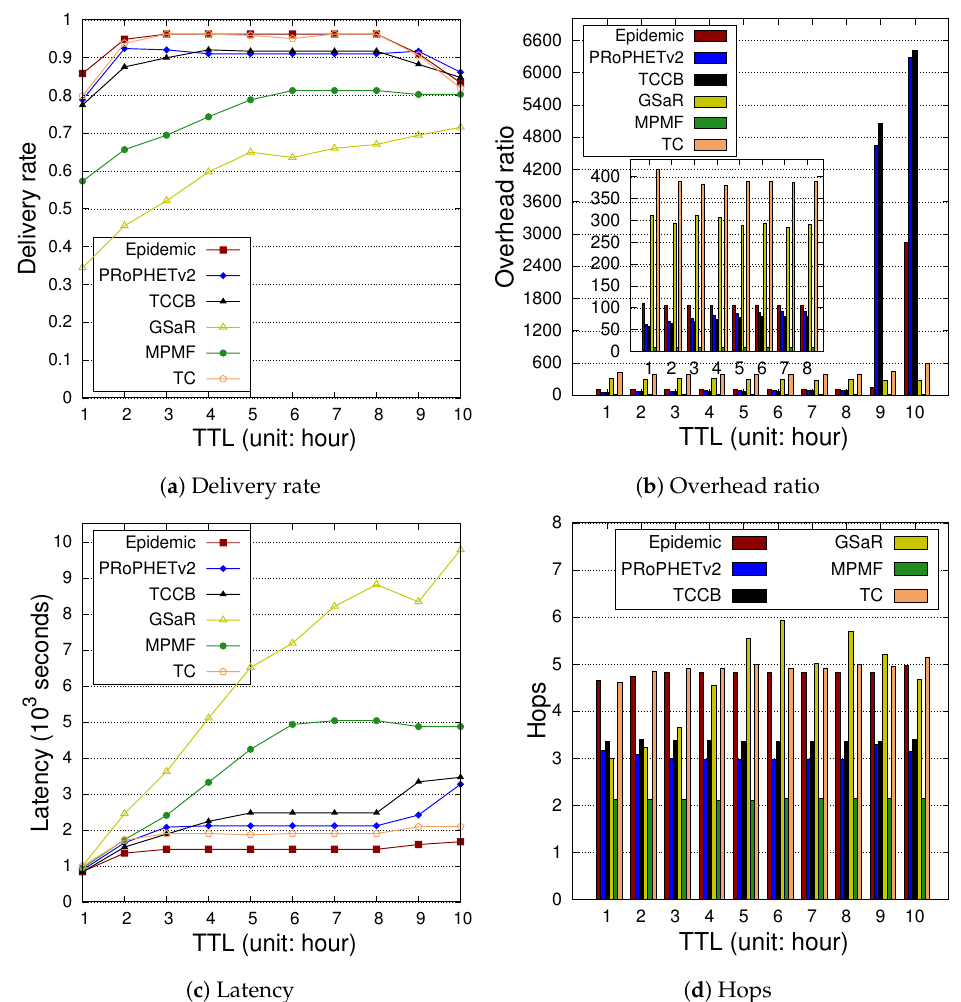
Figure 10. Performance comparison of MPMF in NCCU trace ( W 0 = 0.5, L = 10, (cid:101) = 60, α = 0.6, and buffer size = 10